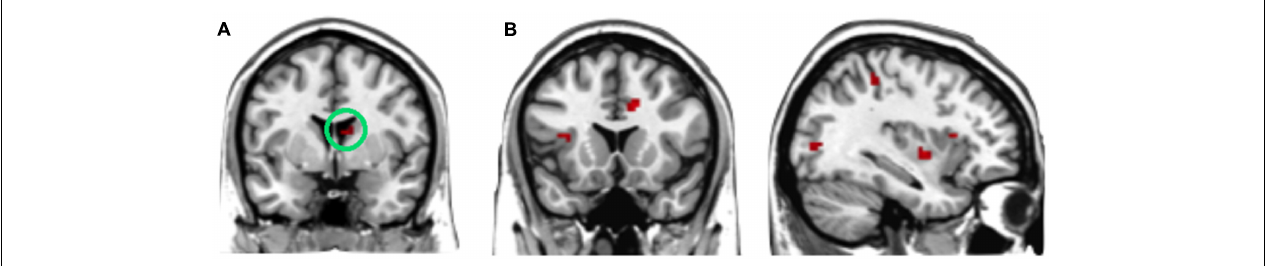
FIGURE 5 | (A) The region of interest was marked with a green circle (dorsal striatum, peak at MNI coordinates: [9, 3, 15]). (B) Results of psychophysiological interaction (PPI) analysis. Functional connectivity with the dorsal striatum in the advantageous inequity influence effects influence (generous offer–selfish influence > generous offer–no social influence). A threshold of p < 0.001, cluster size = 10, uncorrected was used for the